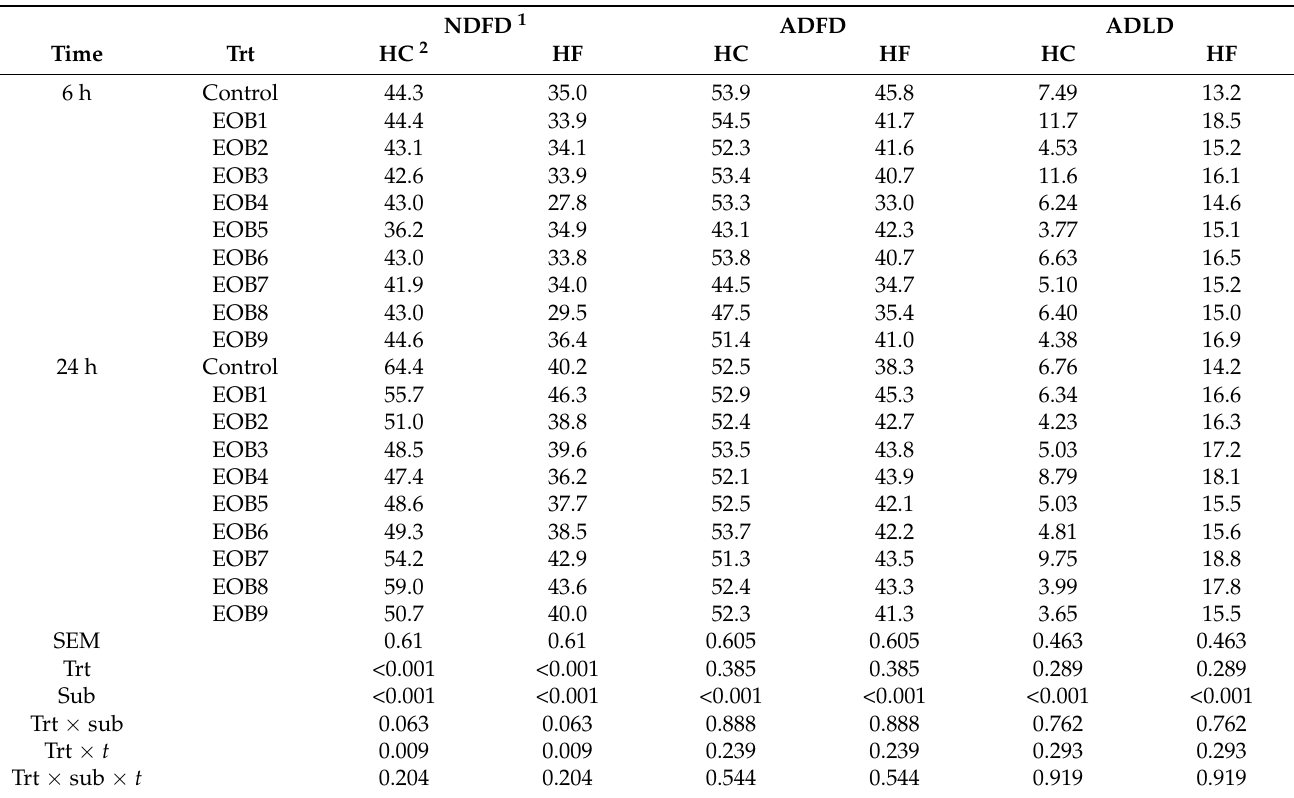
Table 4. The effects of the essential oil blends (EOBs) and time of incubation on NDFD (%), ADFD (%), and ADLD (%) ( n = 6). NDFD 1 ADFD